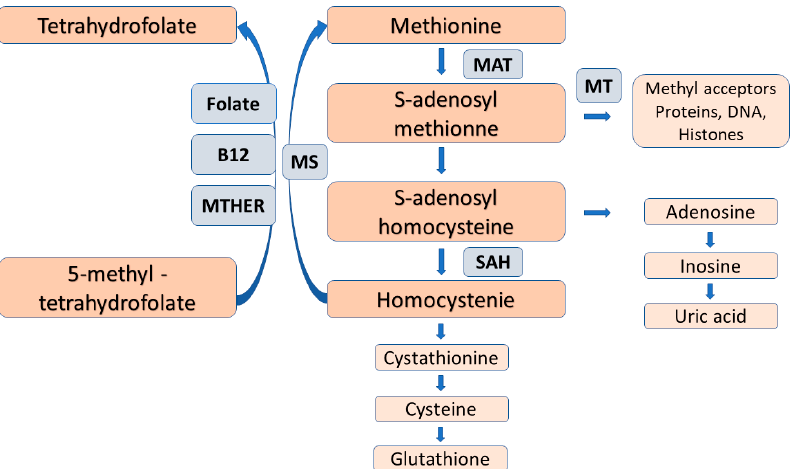
Figure 2. The folate-dependent methionine-homocysteine cycle. Trans-sulfuration of homocysteine for cysteine and glutathione, as well as folate deficiency reduce the reaction by methionine synthase and causes homocysteine accumulation with the subsequent inhibition of the conversion of 5-methyl-tetrahydroforate to the metabolically active folate, tetrahydrofolate. Abbreviations: MAT = methionine adenosyltransferase, MT = methyltransferase, SAAH = S-adenosylhomocysteine hydrolase, MS = methionine synthase, MTAFR = methylene tetrahydrofolate reductase. Taken together, methyl groups are generated as a normal product of cellular metabolism and have a regulatory role in several cellular processes. However, both a low rate and the excessively high rate of methylation have the potential to cause cellular dysfunc- tion, to interfere with the finely tuned, complex interactions of metabolic pathways related to or independent of NO production. As a result, it may compromise healthy development of oocytes and embryos with subsequent pregnancy failure/complications. Unfortunately, the narrow range of methylation optimum has not been defined, therefore, efforts should be made to determine the upper and lower limit of methylation normality outside of which higher risk of fertilization and pregnancy success can be anticipated. 2.3. L-Arginine-Arginase Pathway Arginase is a urea cycle enzyme that hydrolyses l-arginine to urea and l-ornithine. Two distinct arginase isoforms, arginase I and arginase II, have been identified with dif- ferent tissue distribution, cellular location, and immunoreactivity. The two isoforms are encoded by different genes. The cytosolic arginase type I is mainly expressed in the liver and involved in urea synthesis, while mitochondrial type II is widely distributed and plays a critical role in regulating NO synthesis [31–33]. Importantly, arginase competes with NOS for their common substrate, l-arginine, so it may reduce l-arginine bioavailability by redirecting l-arginine catabolism from NO to l- ornithine, which is the precursor of polyamines and proline (Figure 2). It has been well- established that these substrates are intimately involved in various levels of reproductive processes, from folliculogenesis to clinical pregnancies [34]. Furthermore, arginase causes NOS uncoupling, resulting in superoxide and peroxynitrite generation, which further compromises NOS activity [35,36]. It is also to be considered that arginase is co-expressed with NOS in endothelial cells suggesting the mutual tight control of their activity [37]. Concerning the involvement of arginase in regulating reproductive functions, it has been demonstrated in reproductive organs, in particular in the ovarian structures, that it plays a role in the production of ornithine which can be metabolized to polyamines that are required for cell division, proliferation, and differentiation [38,39]. A comprehensive review by Lefevre et al. provides a detailed outline of the critical role of polyamines (putrescine, spermidine, spermide) in female reproduction.